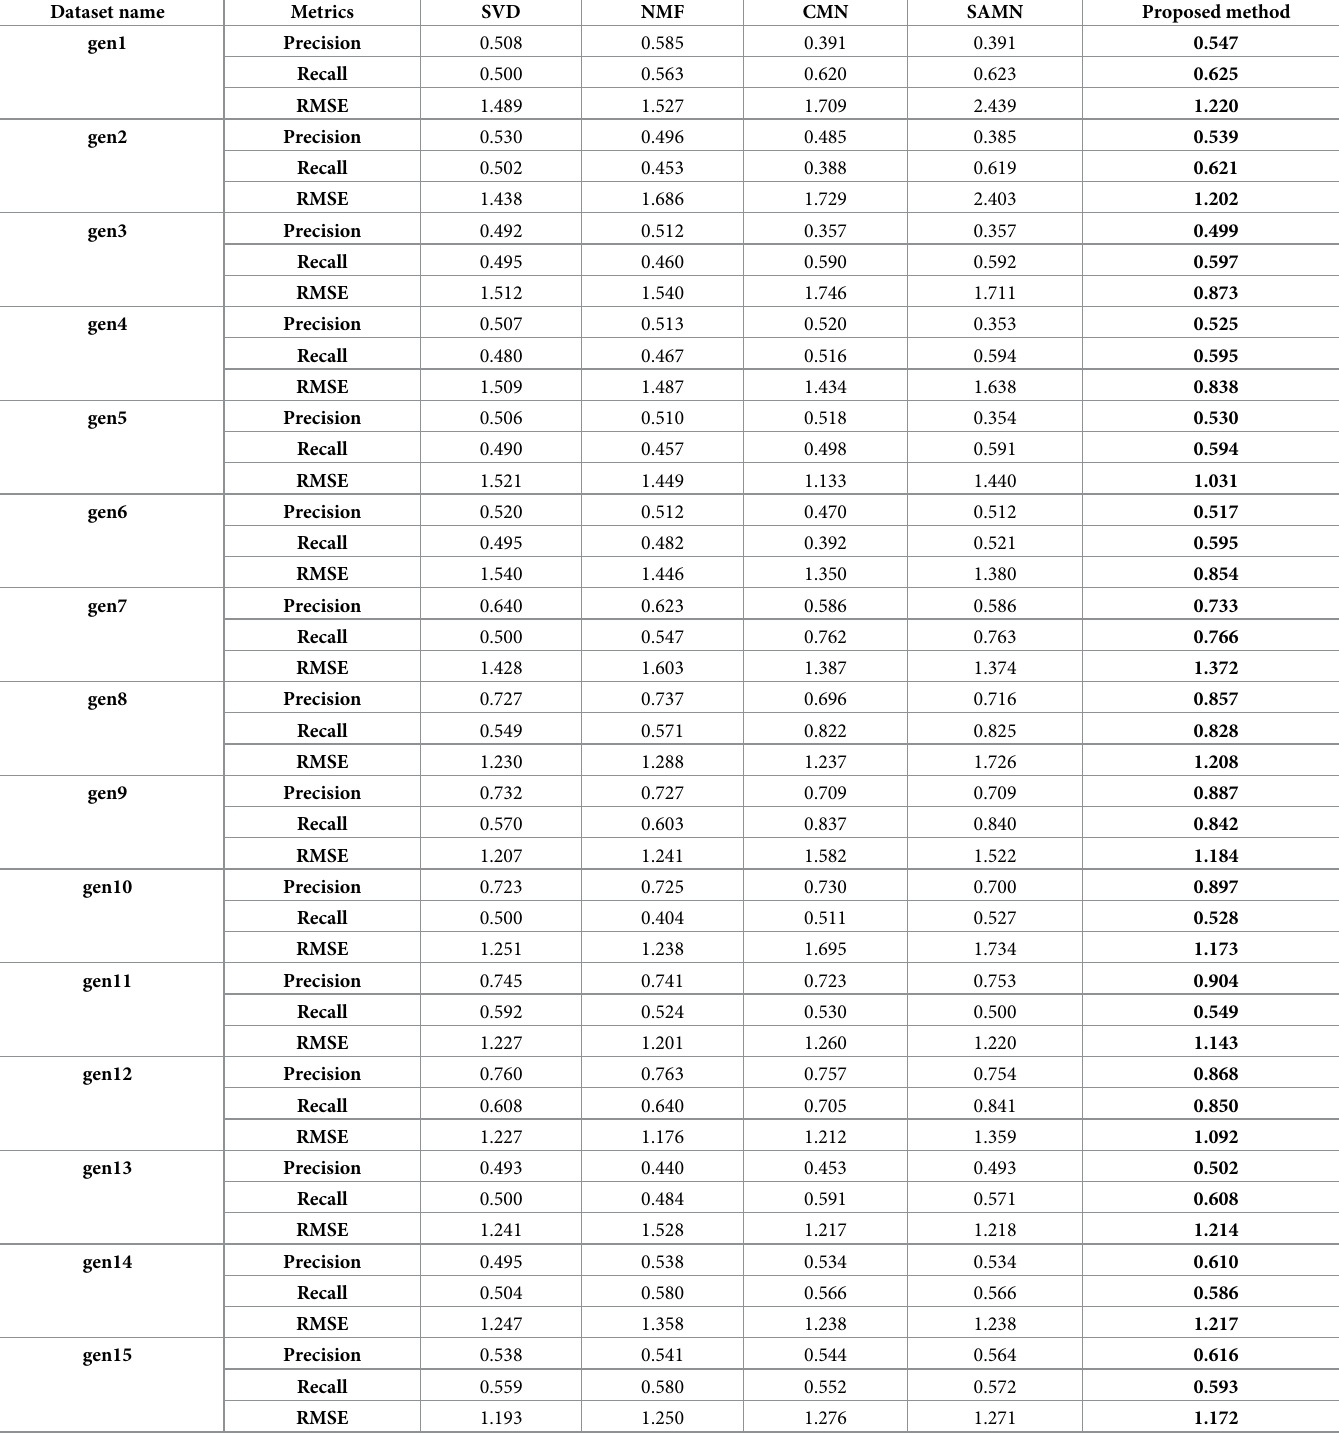
Table 11. The accuracy experimental results of synthetic data. Dataset